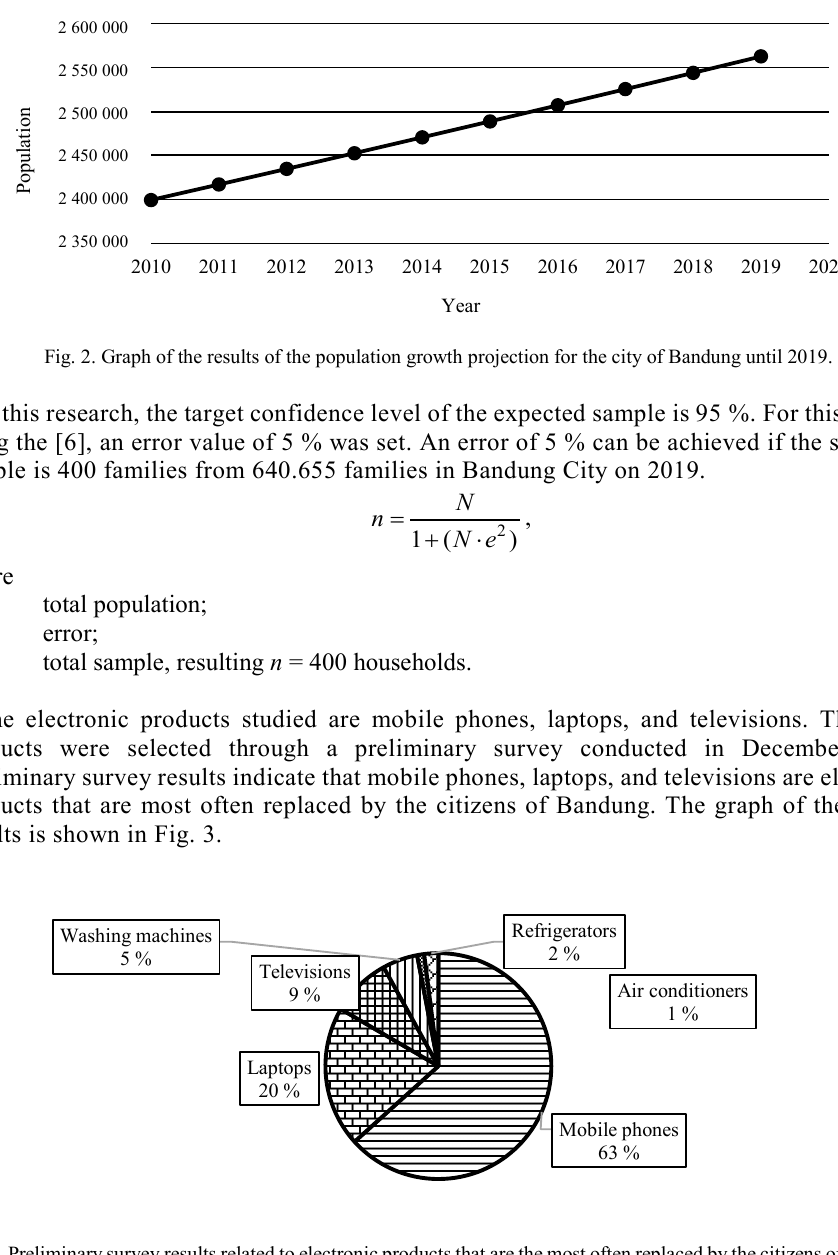
Fig. 3. Preliminary survey results related to electronic products that are the most often replaced by the citizens of